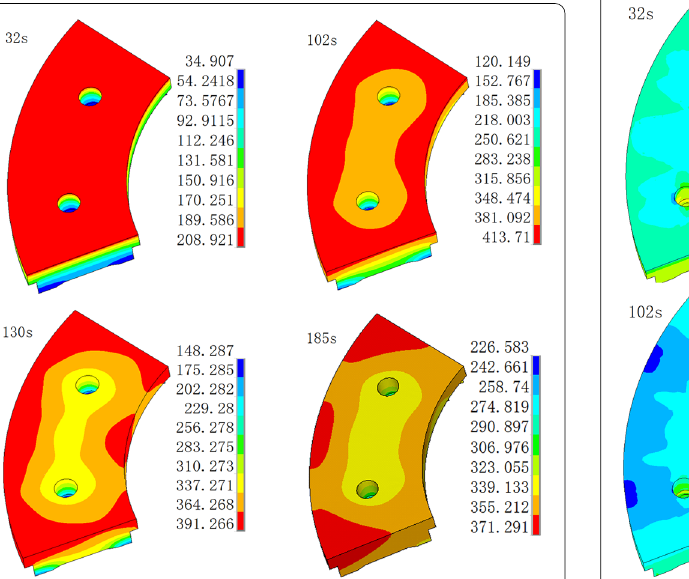
Figure 8 Temperature contour of brake disc ( ℃ )